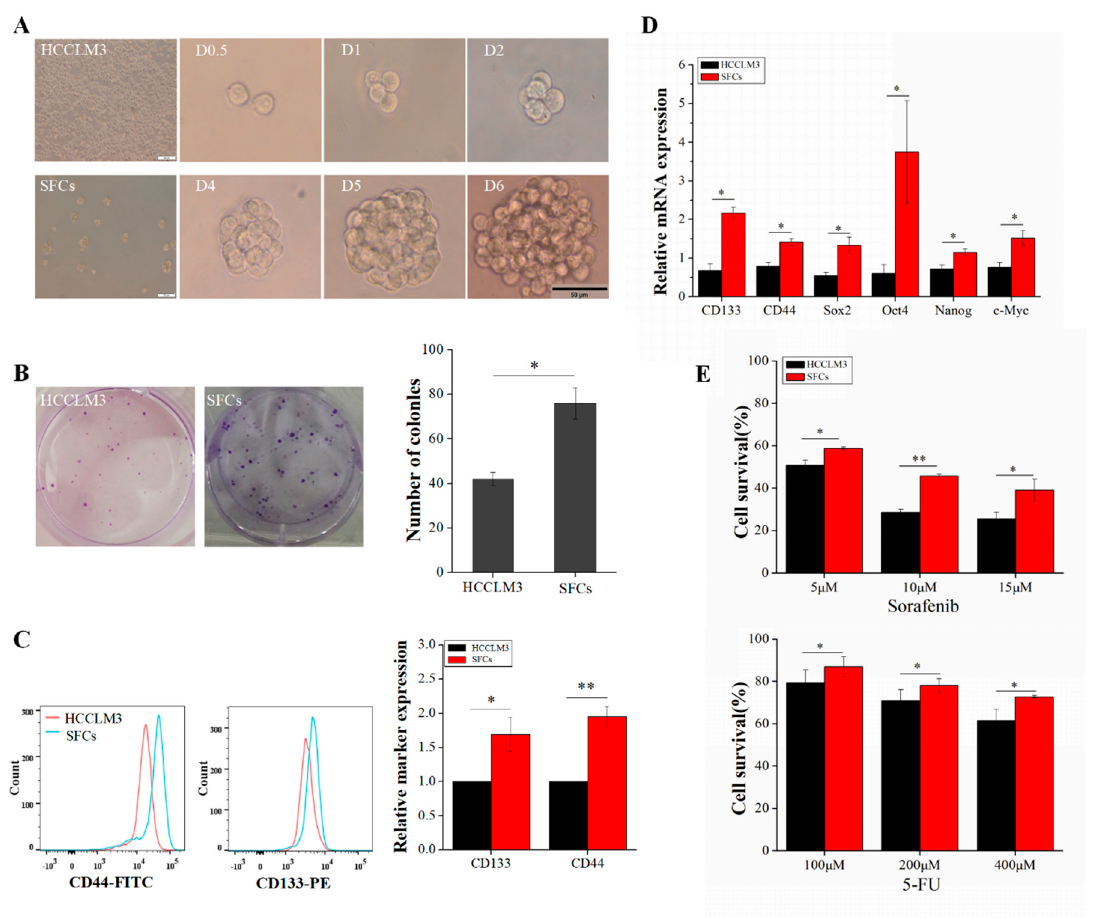
Figure 1. Enrichment and characterization of liver cancer stem cells (LCSCs) from HCCLM3 cells. ( A ) Morphological characteristics of HCCLM3 and sphere-forming cells (SFCs); process of sphere formation from a single P3 SFC (scale bar = 50 µm). ( B ) Comparison of the clonogenicity of HCCLM3 cells and SFCs in vitro. ( C ) Detection of the surface markers CD133 and CD44. ( D ) Detection of stemness genes. ( E ) Drug resistance analysis of SFCs and HCCLM3 cells. HCCLM3 cells and SFCs were treated with 5-FU and sorafenib for 12 h. Cell survival was determined by a CCK8 assay. Relative values are presented as the means ± standard deviation (SD) of three independent experiments. n = 3; * p < 0.05 and ** p < 0.01.